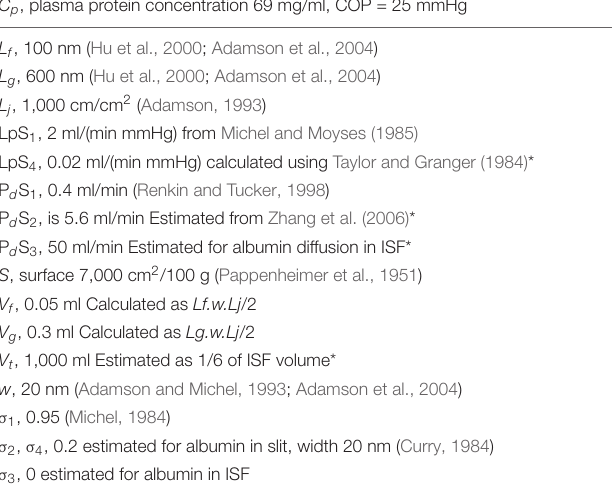
TABLE 2 | Model parameters.